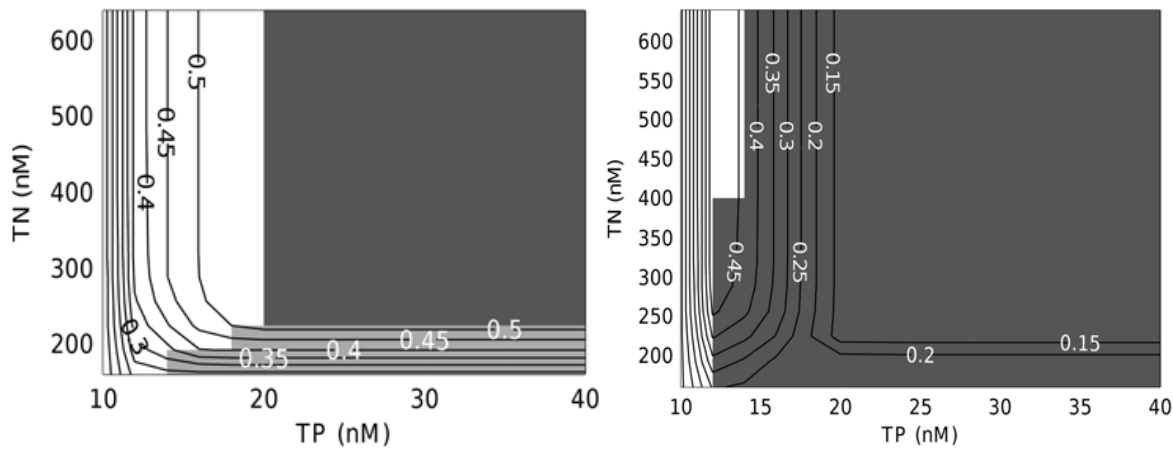
Fig. 4. Phytoplankton and bacterial growth rates per day as a function of total nitrogen (TN) and total phosphate (TP). Background color rep- resents the element which is most limiting growth. (white color represents P-limitation, light grey, N-limitation and dark grey C-limitation).